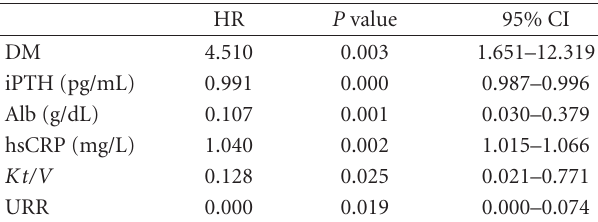
Table 2: Univariate analyses of characteristics associated with APD.